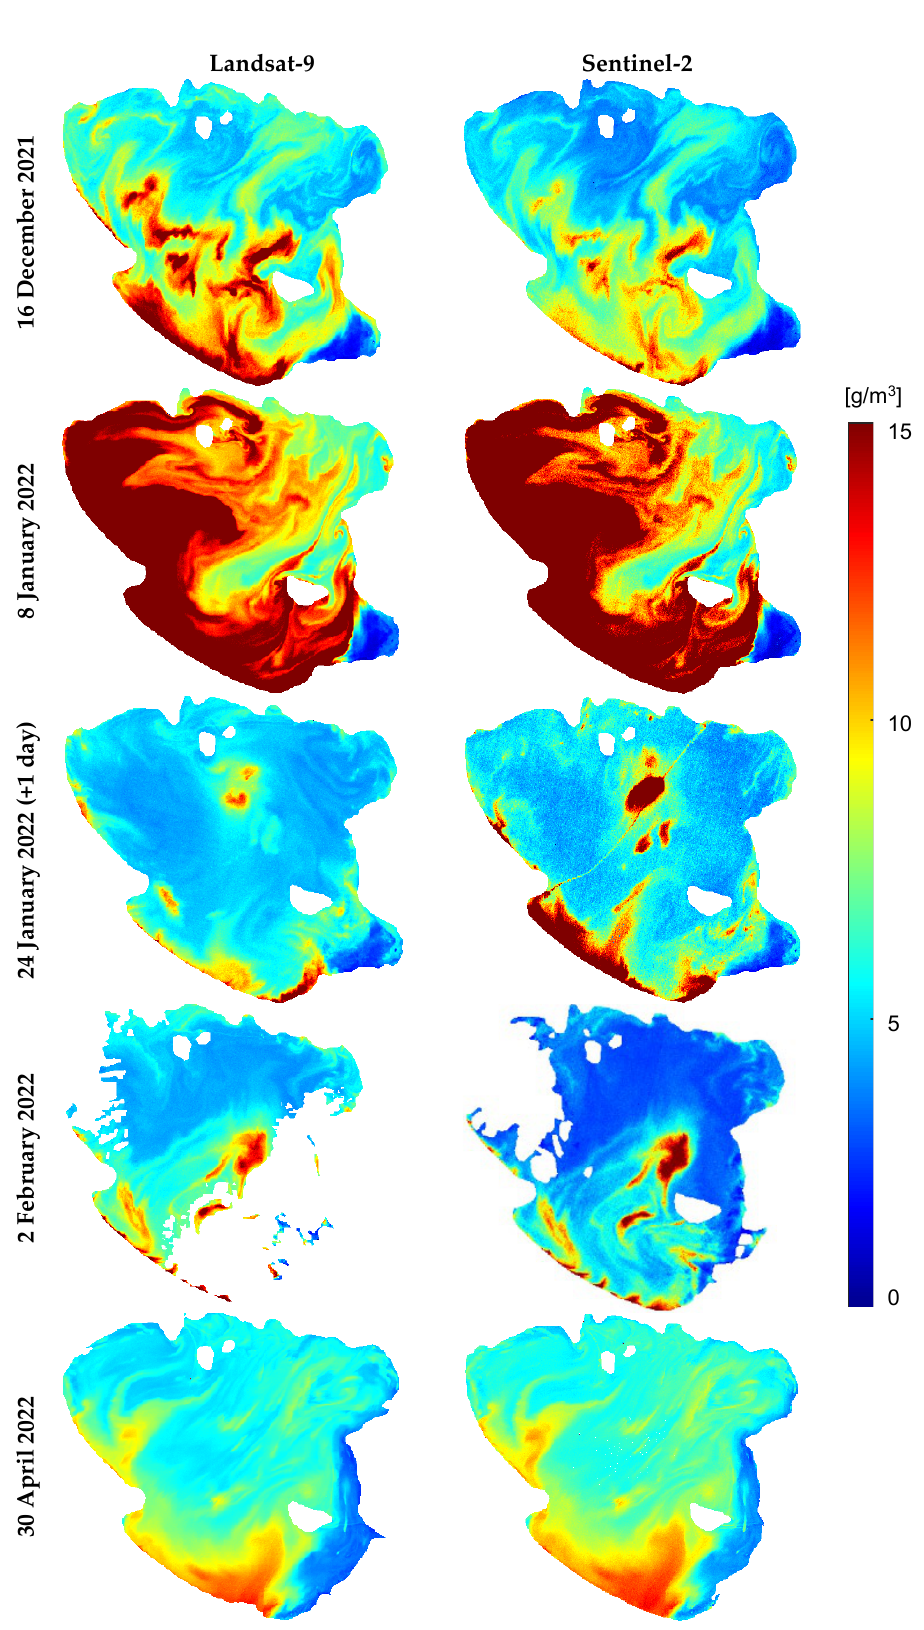
Figure 8. TSM maps derived from Landsat-9 and Sentinel-2 imagery in Lake Trasimeno using BOMBER.